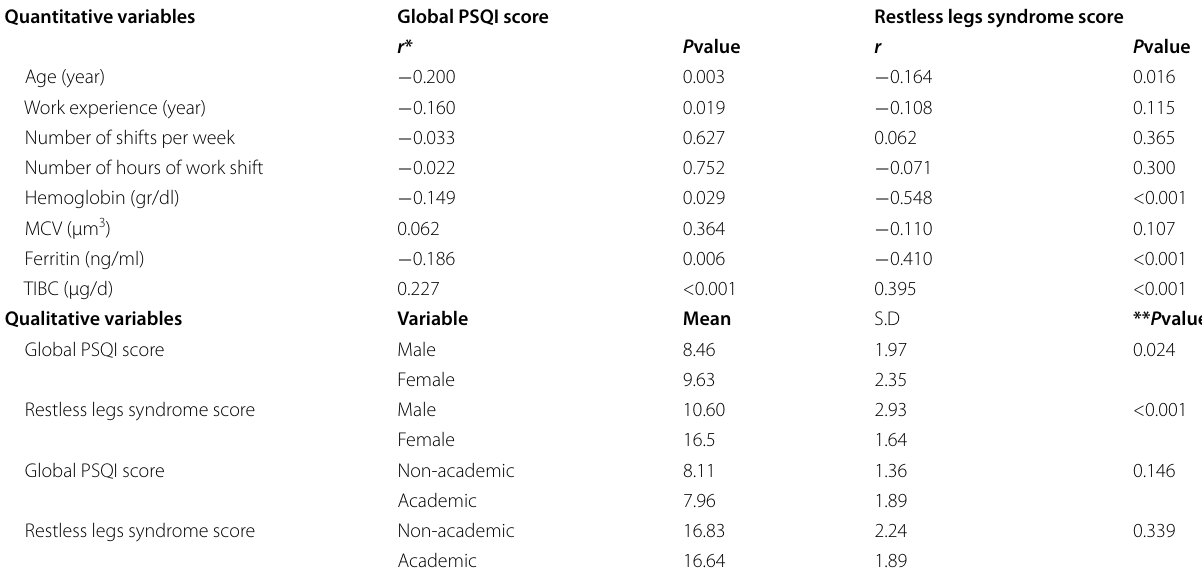
Table 4 Relationship between demographic, occupational characteristics, and laboratory parameters with global PSQI and restless legs syndrome scores in the workers under